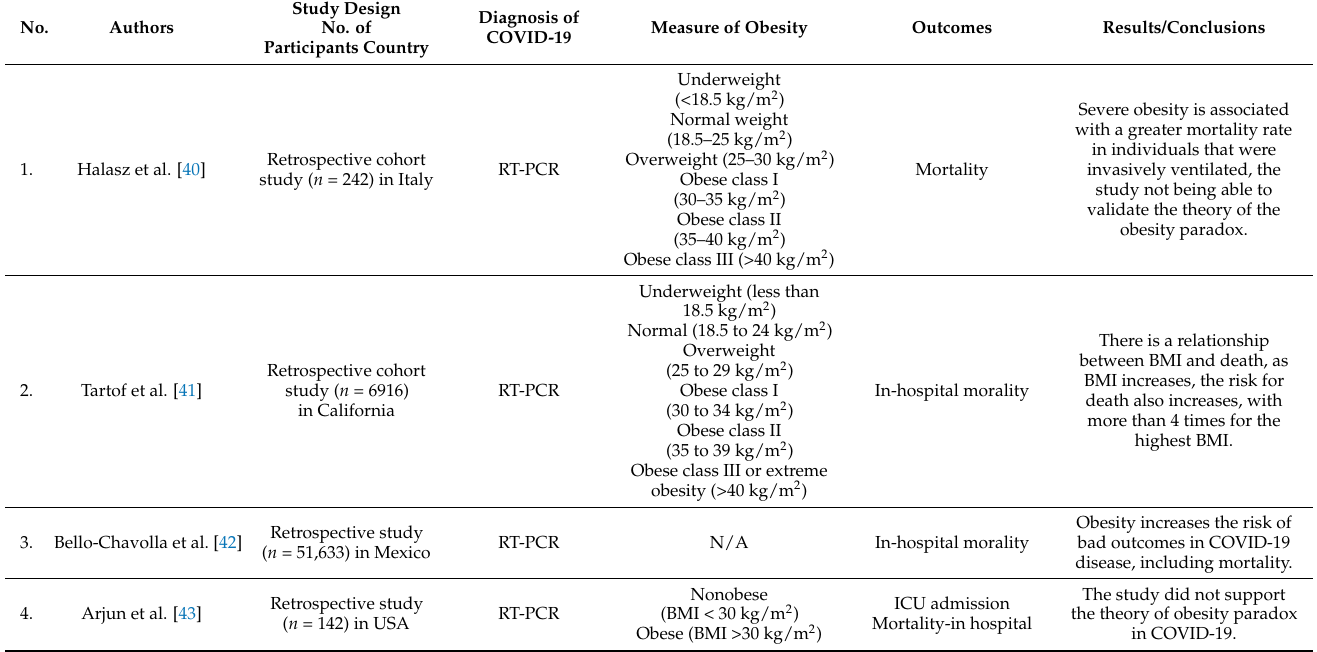
Table 2. Studies not supporting the theory of